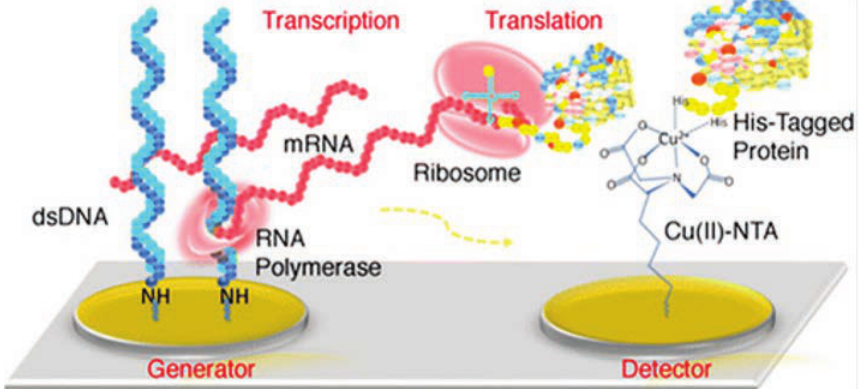
Figure 1. Schematic diagram of the on-chip synthesis of protein microarray from DNA microarray via surface in vitro transcription-translation. Reprinted with permission from [34]. Copyright 2012 American Chemical Society [34].